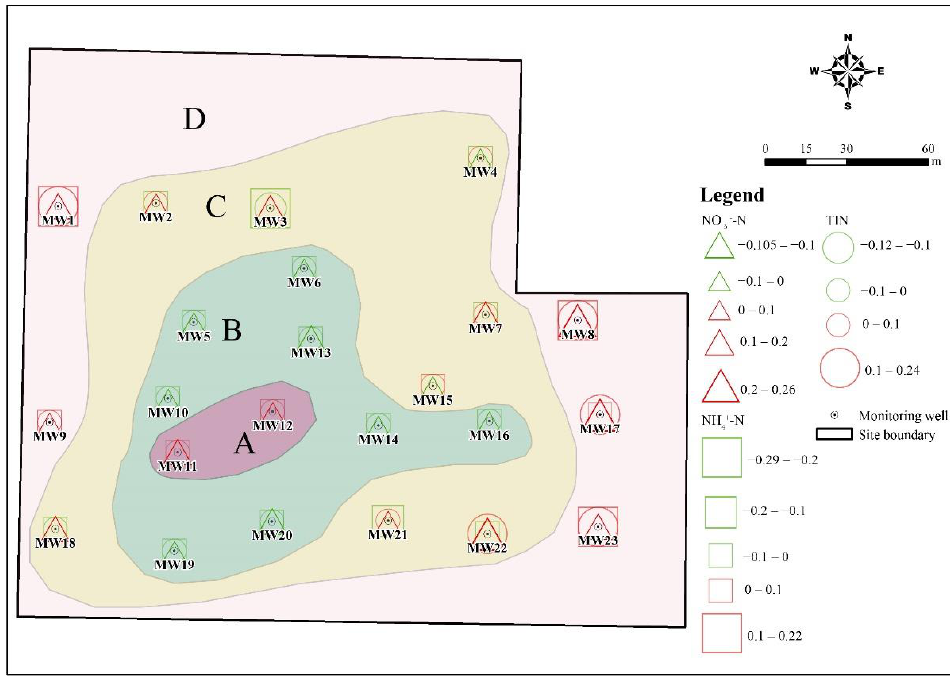
Figure 10. Map showing the temporal trends of DIN species in the monitoring wells. The triangle, square, and circle represent the estimated slopes of log 10 NO 3 − -N, NH 4+ -N, and TIN, respectively. Green color indicates a negative slope, whereas red color indicates a positive slope.